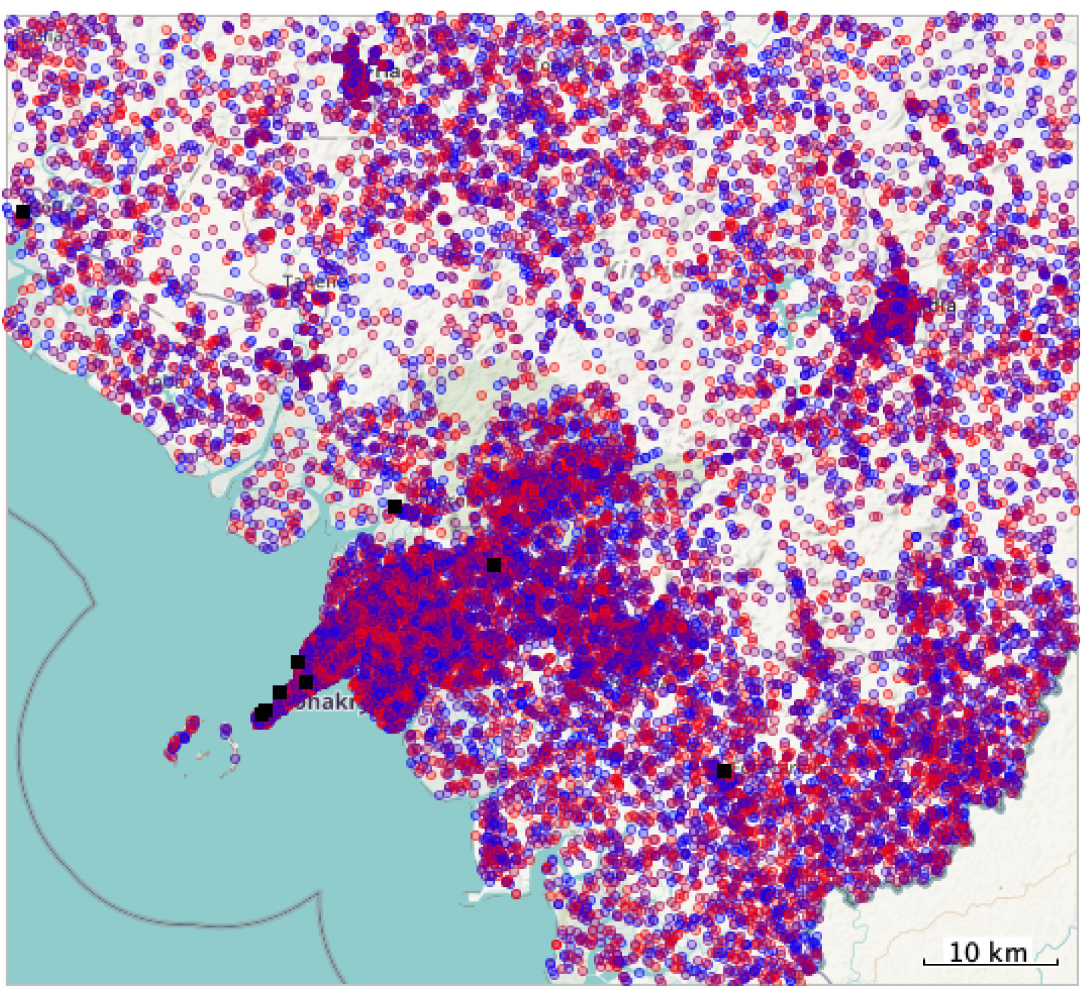
Fig 1. Population and hospital placement in the agent-based model. Hospitals are represented by black squares. The population is represented with circles shaded blue (poorest) to red (richest). Conakry, the capital of Guinea, is located on the densely-populated peninsula toward the southwest in this